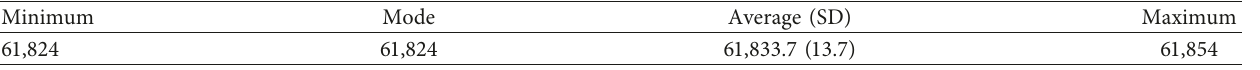
Table 2: Statistics of clock cycle count required for DPR in the EU-swapping experiment.